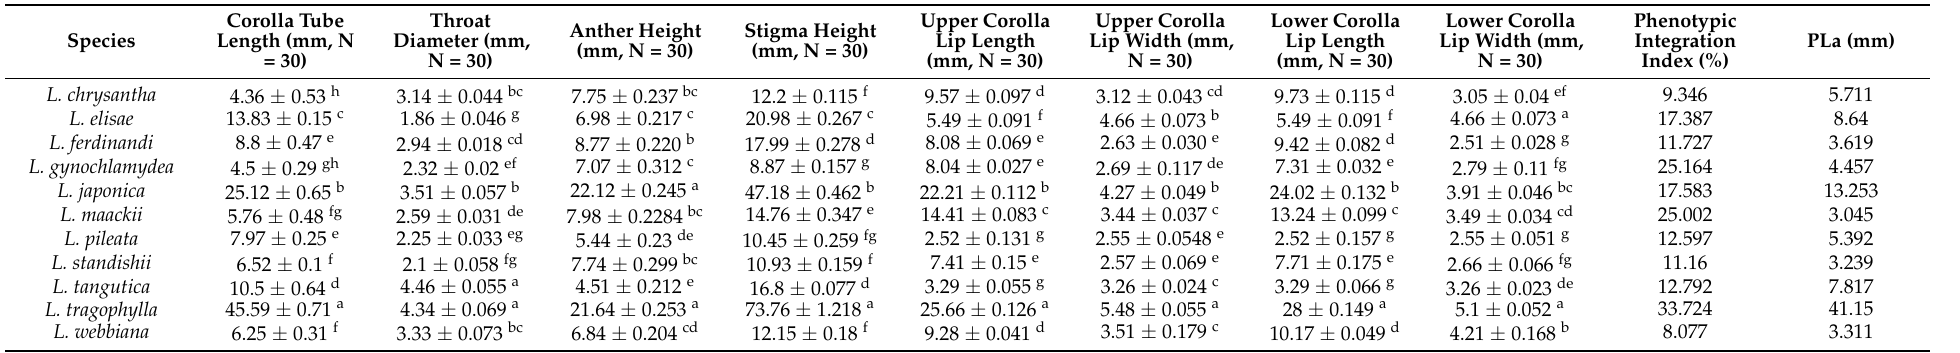
Table 1. Floral traits (corolla tube length, throat diameter, anther height, stigma height upper corolla lip length/width, and lower corolla lip length/width), phenotypic integration index (INT), and the composite pollinator proboscis length (PLa) for the 11 Lonicera species. All the traits were measured in one natural study population of each species. Different letters indicate significant differences among species (Tukey post hoc